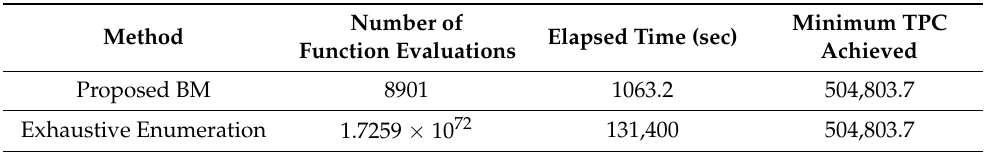
Figure 5. Optimal economic dispatch of the proposed approach. Table 6. Comparative results pertaining the 10-unit